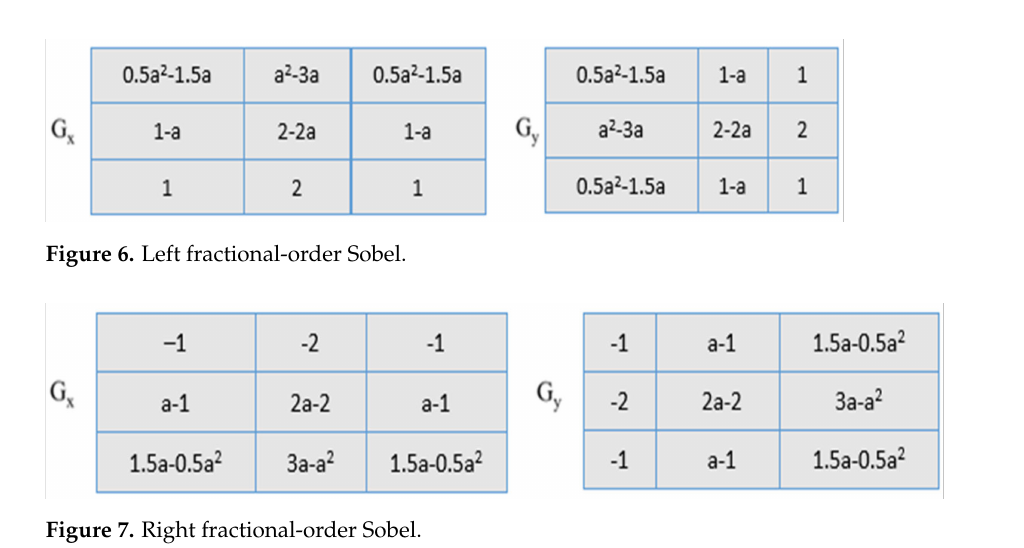
Figure 7. Right fractional-order